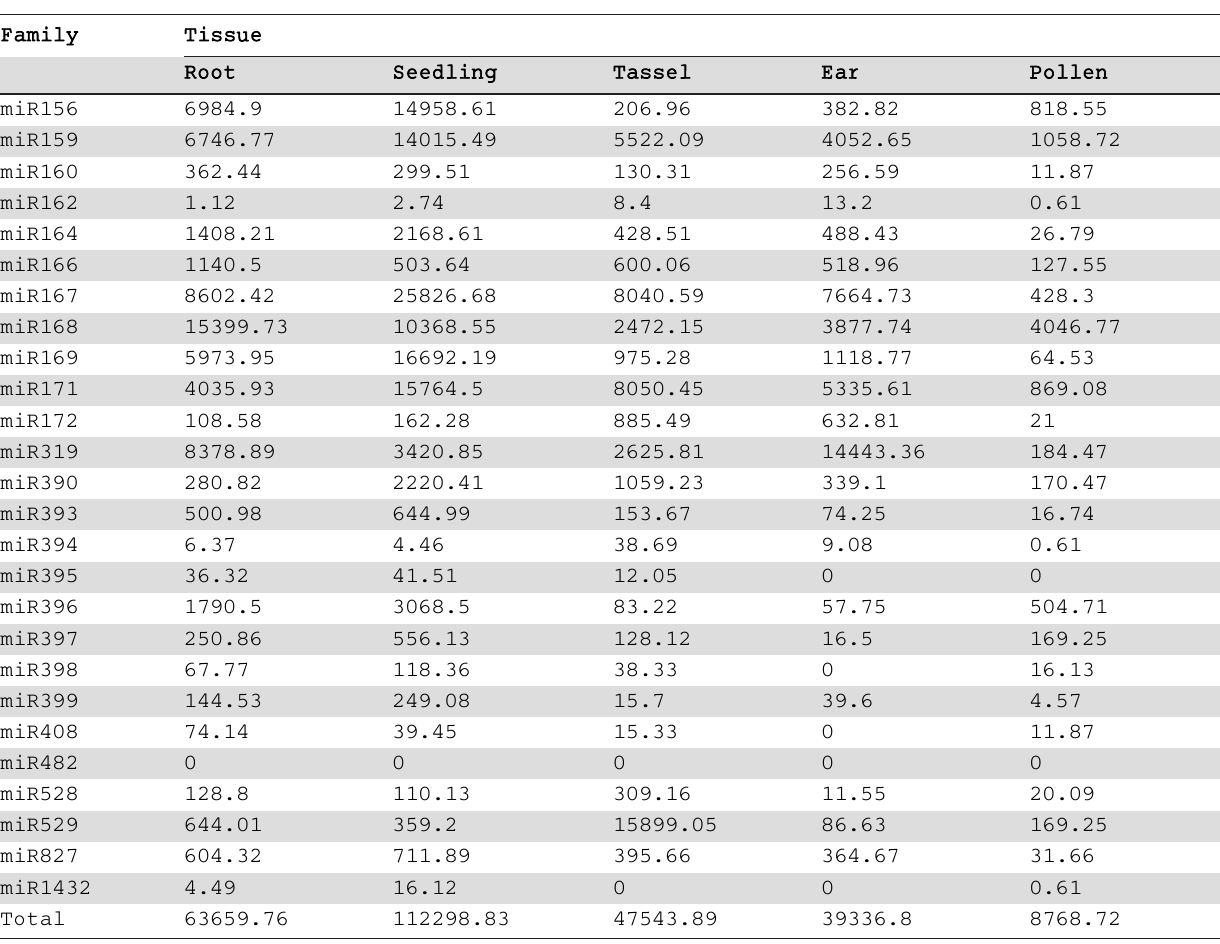
Table 3. Expression levels of maize miRNA genes assessed using Solexa